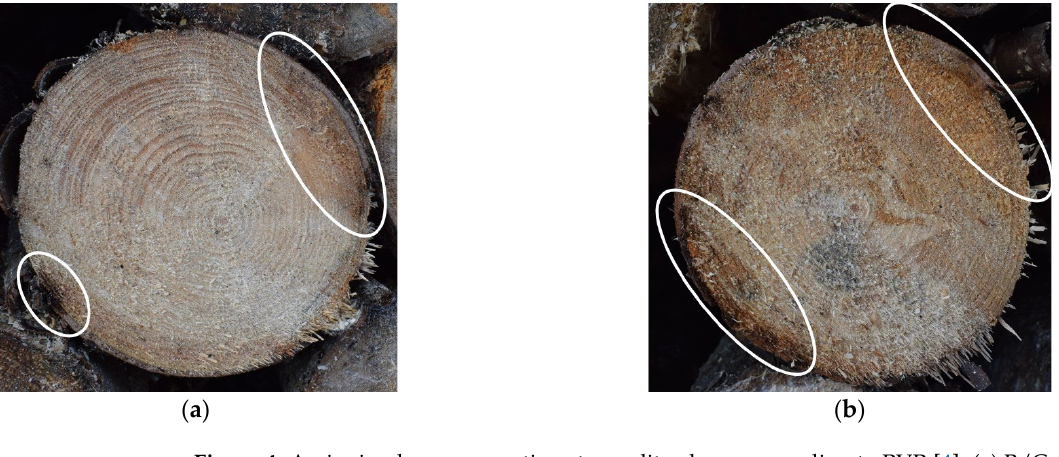
Figure 4. Assigning log cross-sections to quality classes according to RVR [4]. ( a ) B/C quality with acceptable rot spots at the edge of the cross-section; ( b ) D quality log with signs of softening due to brown rot.